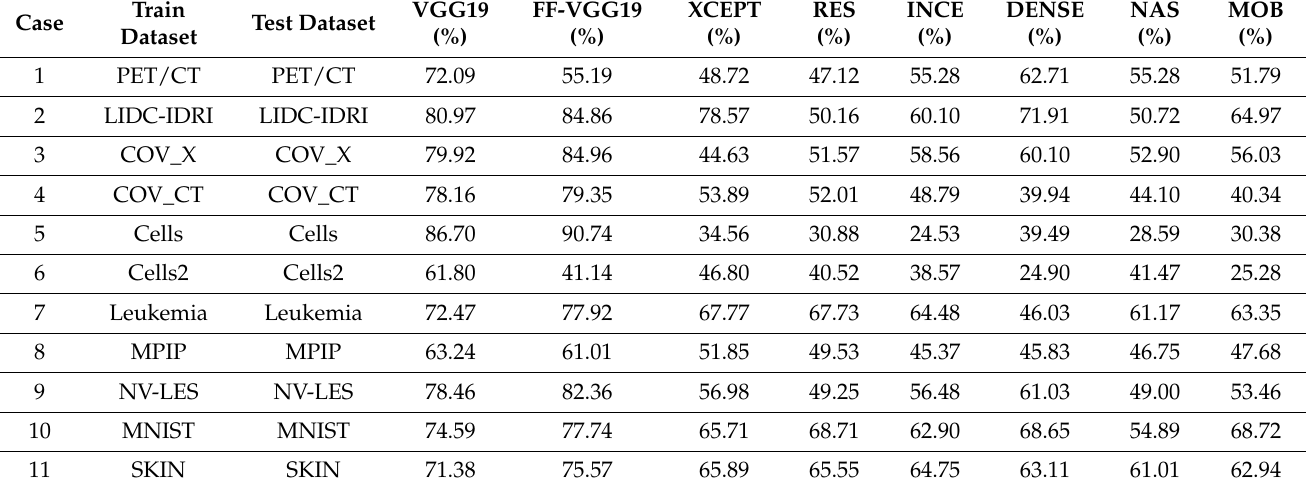
Table 5. Classification accuracy (%) of employed CNNS, utilising off-the-shelf features. The table columns refer to the various networks employed for the classification. XCEPT refers to Xception, RES refers to ResNet, INCE refers to InceptionV3, DENSE refers to DenseNet, NAS refers to NasNet, and MOB refers to MobileNet. The evaluation is based on a 10-fold